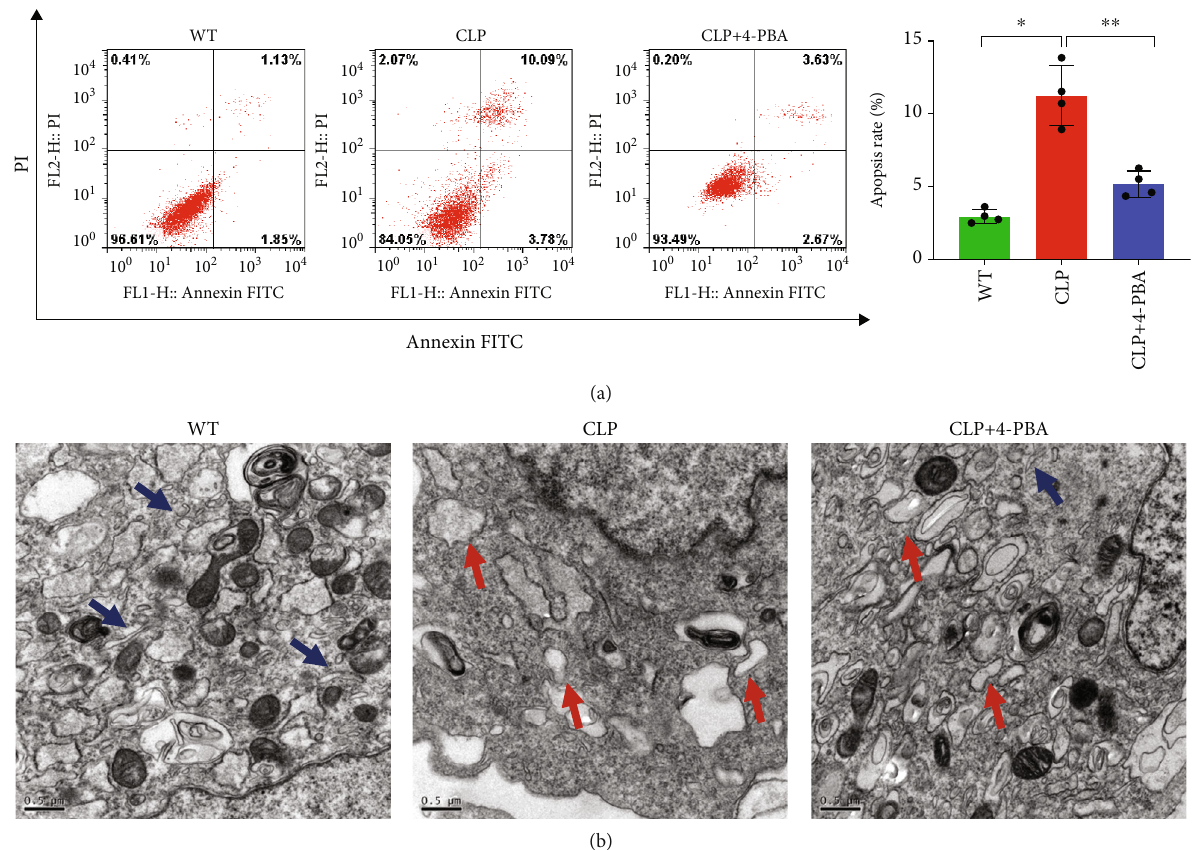
Figure 4: ERS-induced apoptosis leads to CD4 + T cell apoptosis in CLP mice. Apoptosis in CD4 + T cells from WT, CLP, and CLP+4-PBA mice was assessed by fl ow cytometry analysis. Apoptosis ratios are the early apoptosis percentage plus the late apoptosis percentage (a). x -axis: V- FITC; y -axis: PI. Left panel: gating strategy for apoptosis cells; right panel: percentage of apoptotic cells in the left panel. Graphs show means ± SD , four to six mice per group. Representative images of ER in CD4 + T cells from WT, CLP, and CLP+4-PBA mice, as observed by electron microscopy (b). Data are mean ± SD , n = 4 (one-way ANOVA Dunnett ’ s post hoc test). Blue arrows represent normal-sized ER. Red arrows represent dilation and vesiculation of the ER. Scale bars = 0 : 5 μ m . FITC: fl uorescein isothiocyanate; PI: propidium